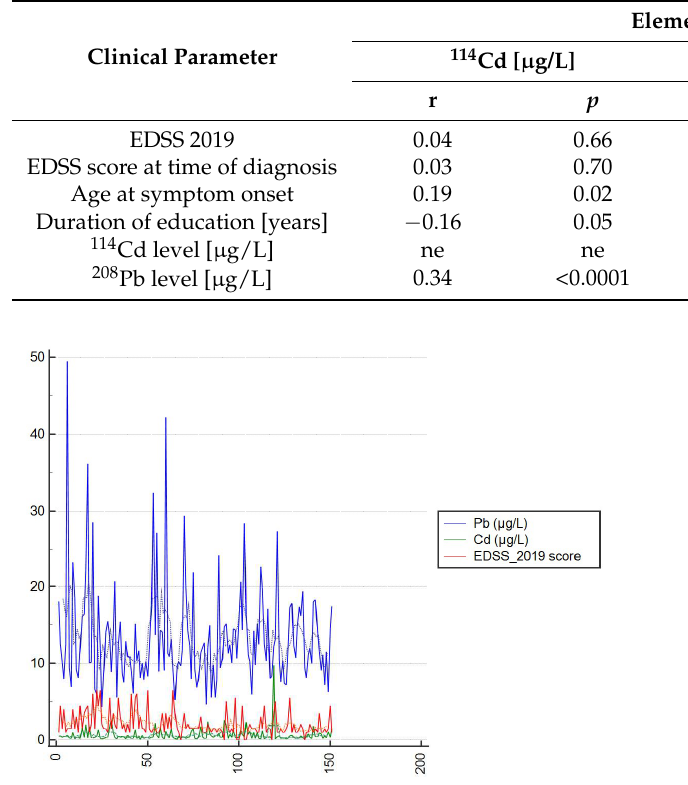
Figure 3. Correlation between the EDSS-BL scores and the levels of the tested elements. Dotted lines represent trendlines.